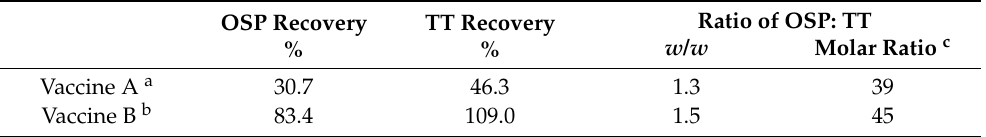
Table 2. Analysis of OSP-TT Conjugates.